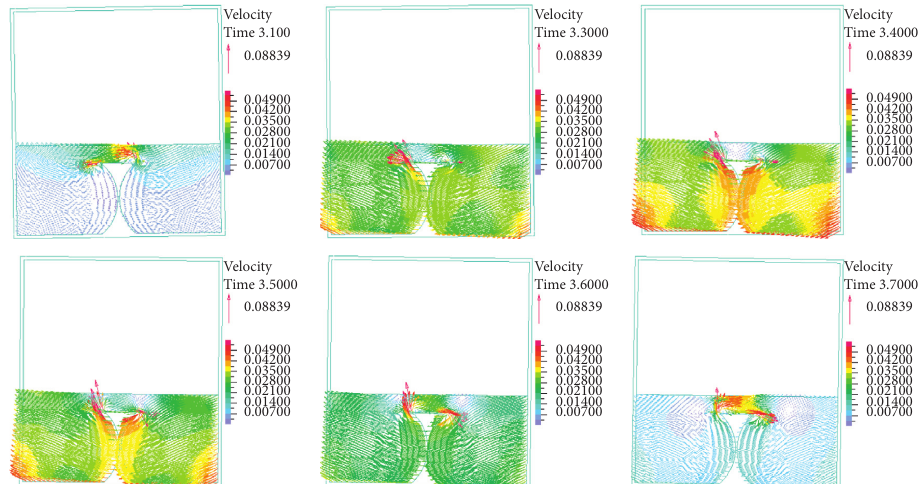
Figure 18: Evolution of velocity field under coupled excitations of surge and pitch, A � 0.01 m and θ � 1 °